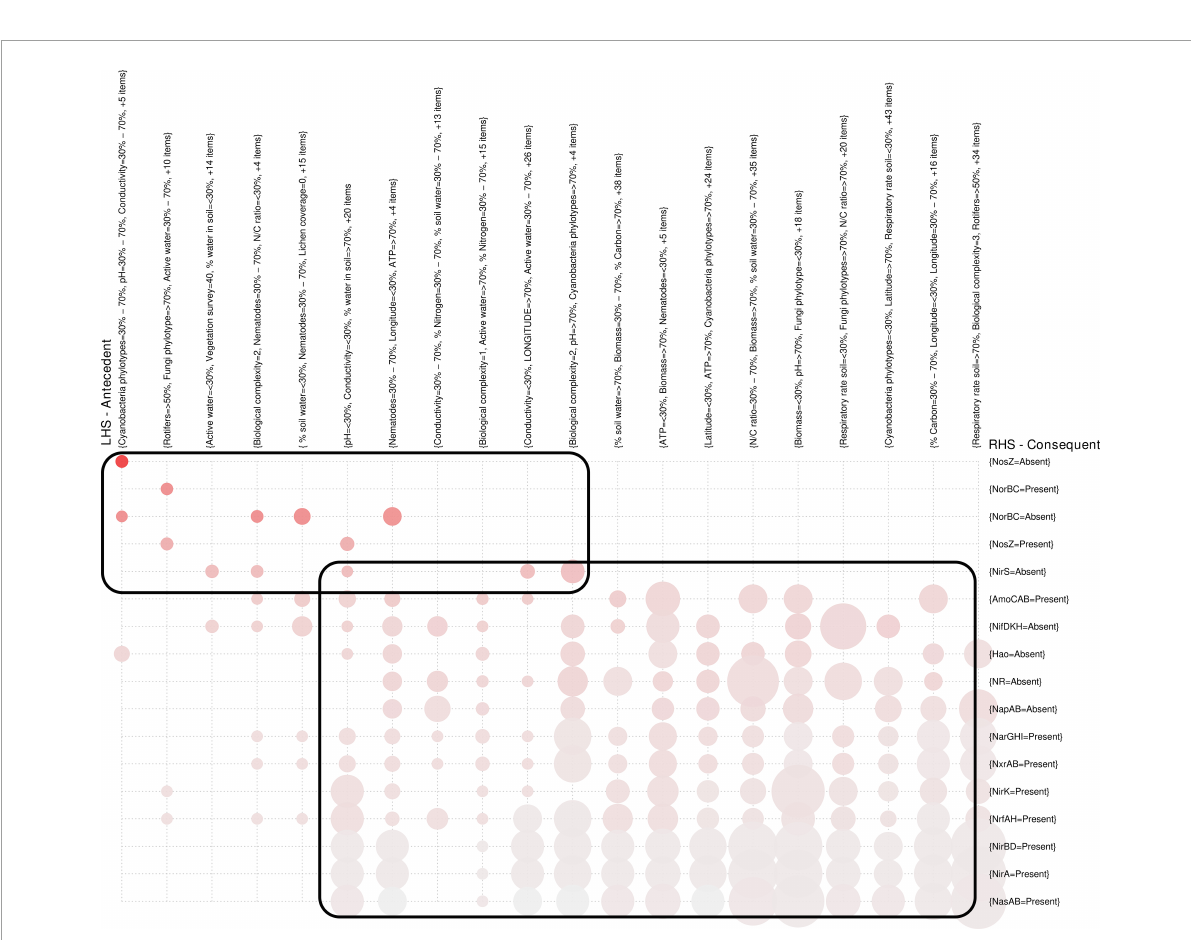
FIGURE6 Association rules between presence/absence of operons and biogeochemical variables. Illustration of a clustering of the most significant association rules ( n = 676), with size as support, color as lift and consequent/antecedent of the association rules specified in the text, with lines as presence/absence of the entire operons and columns as association rules for those operons. More specifically, the columns describe the left hand side (LHS), or antecedent, and the lines describe the right hand side (RHS), or consequent. For example, for the presence of operons for NorBC there was a clustering with association rules corresponding to the environmental variables of Rotifers (with values superior to 50% of samples), fungi phylotype (with values superior to 70% of samples), active water (with values within the range of 30–70% of samples) and 10 other variables that were omitted due to visualization constraints (indicated as “+10 items”). The full description of the association rules clustered in this figure are available in Supplementary Table 6